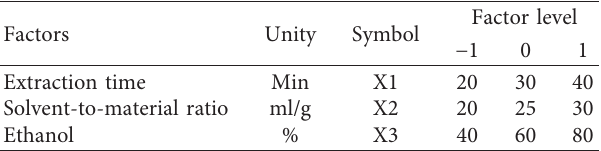
Table 1: The selected factors and their levels in the Box–Behnken design.